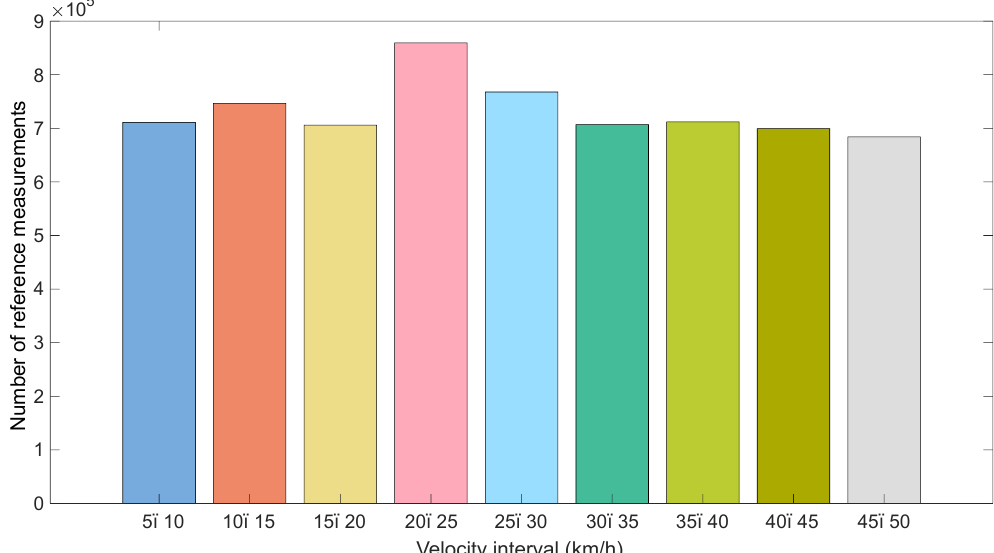
Figure 4. Histogram of the generated dataset. Each color indicates a velocity range of the refer- ence data.